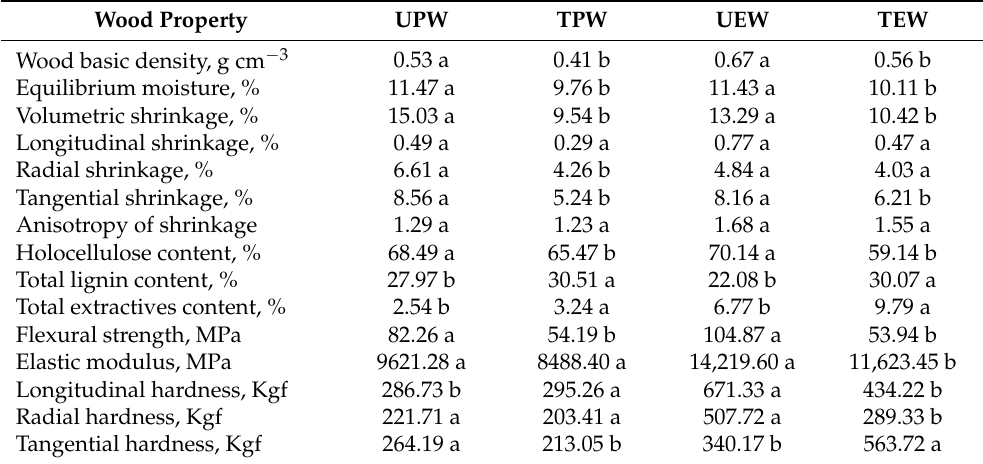
Table 1. Wood characteristics of Pinus taeda and Eucalyptus grandis wood before and after the thermal